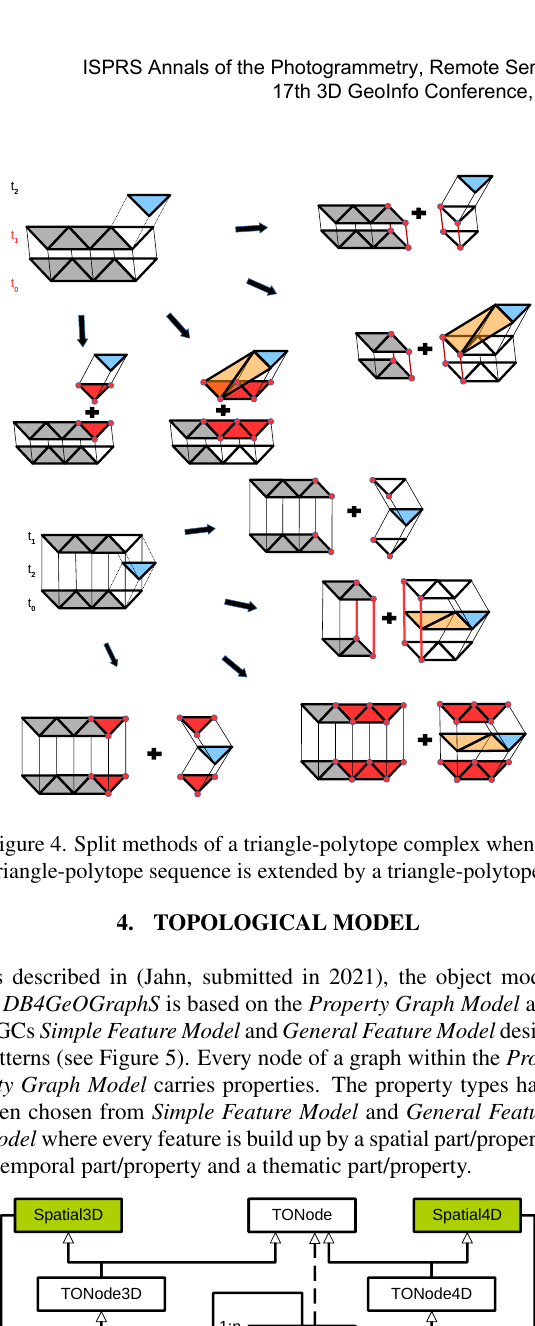
Figure 6 (top: spatial model, bottom: spatio-temporal model) illustrate two examples using DB4GeOGraphS model. It is